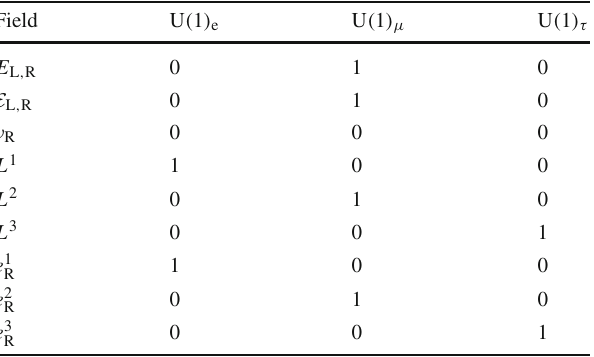
Table 3 Quantum numbers under the approximate lepton number sym- metry